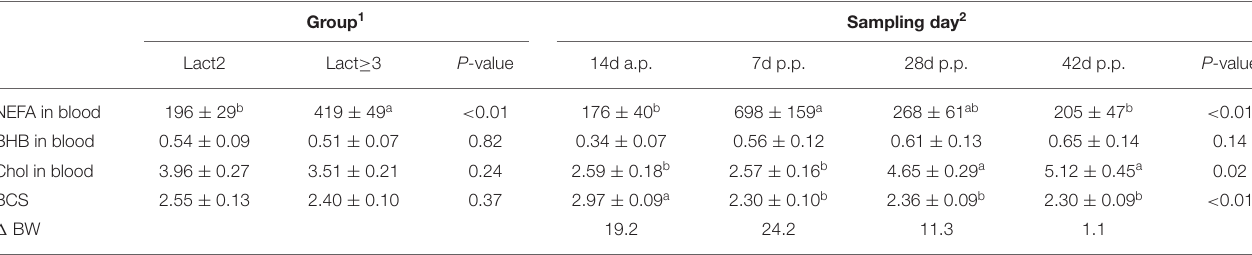
TABLE 2 | Least square means ± standard errors and F-test results ( P- values) for non-esterified fatty acids (NEFA, µ mol/l serum), ß-hydroxybutyrate (BHB; mmol/l plasma), and cholesterol (Chol, mmol/l plasma) in blood, and for the body condition score [BCS; according to Edmonson et al. ( 37)] of both groups and at four sampling days for both groups combined, and differences in body weight (BW, kg) between groups at four sampling